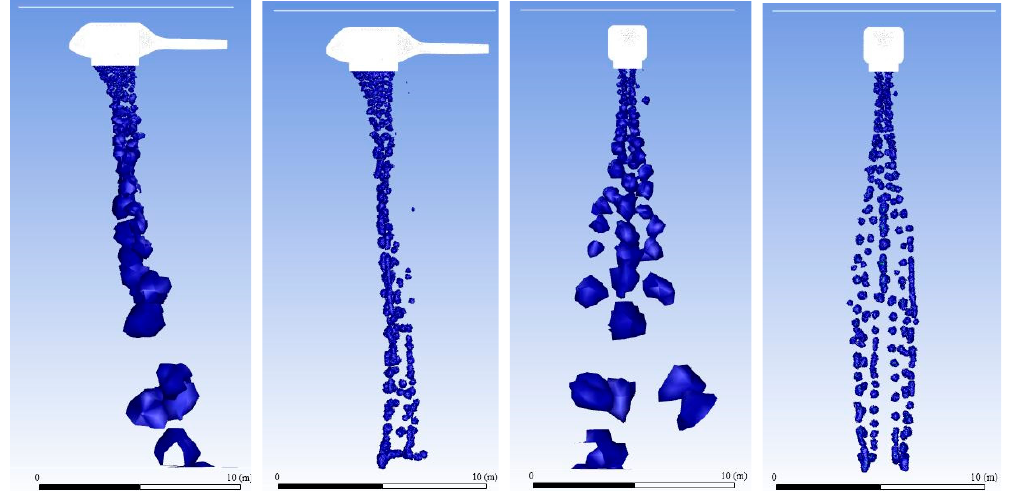
Figure 8. Contour surface of the side view and front view for a two-phase, water–air volume fraction of 0.01 at t = 1.9 s. of 0.01 at t = 1.9